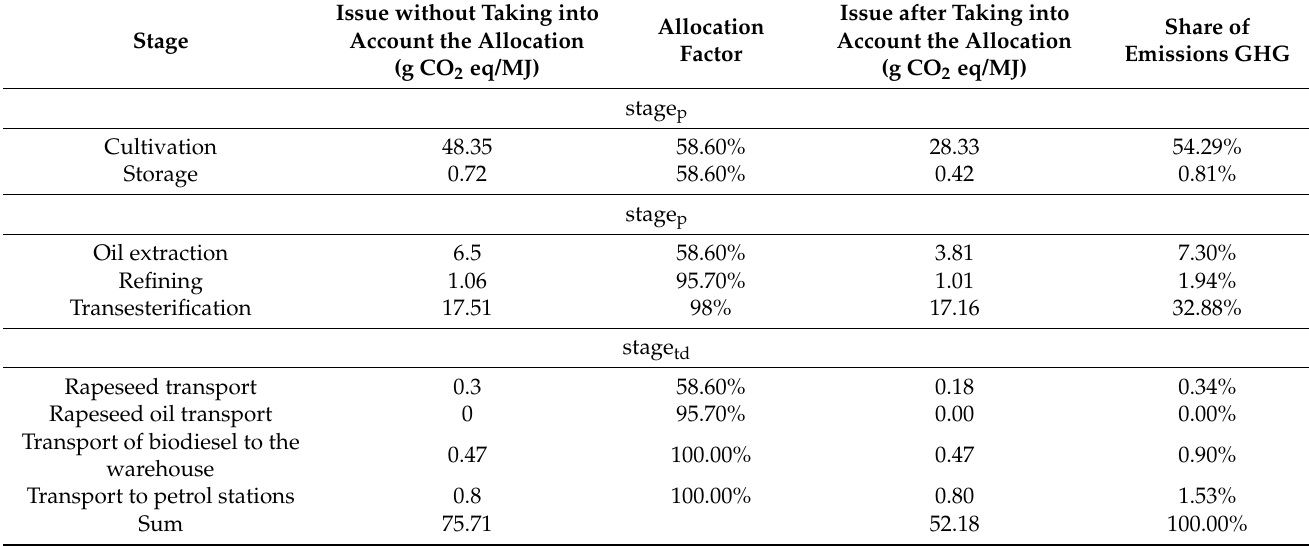
Table 17. GHG emissions in the life cycle of a biofuel based on the energy